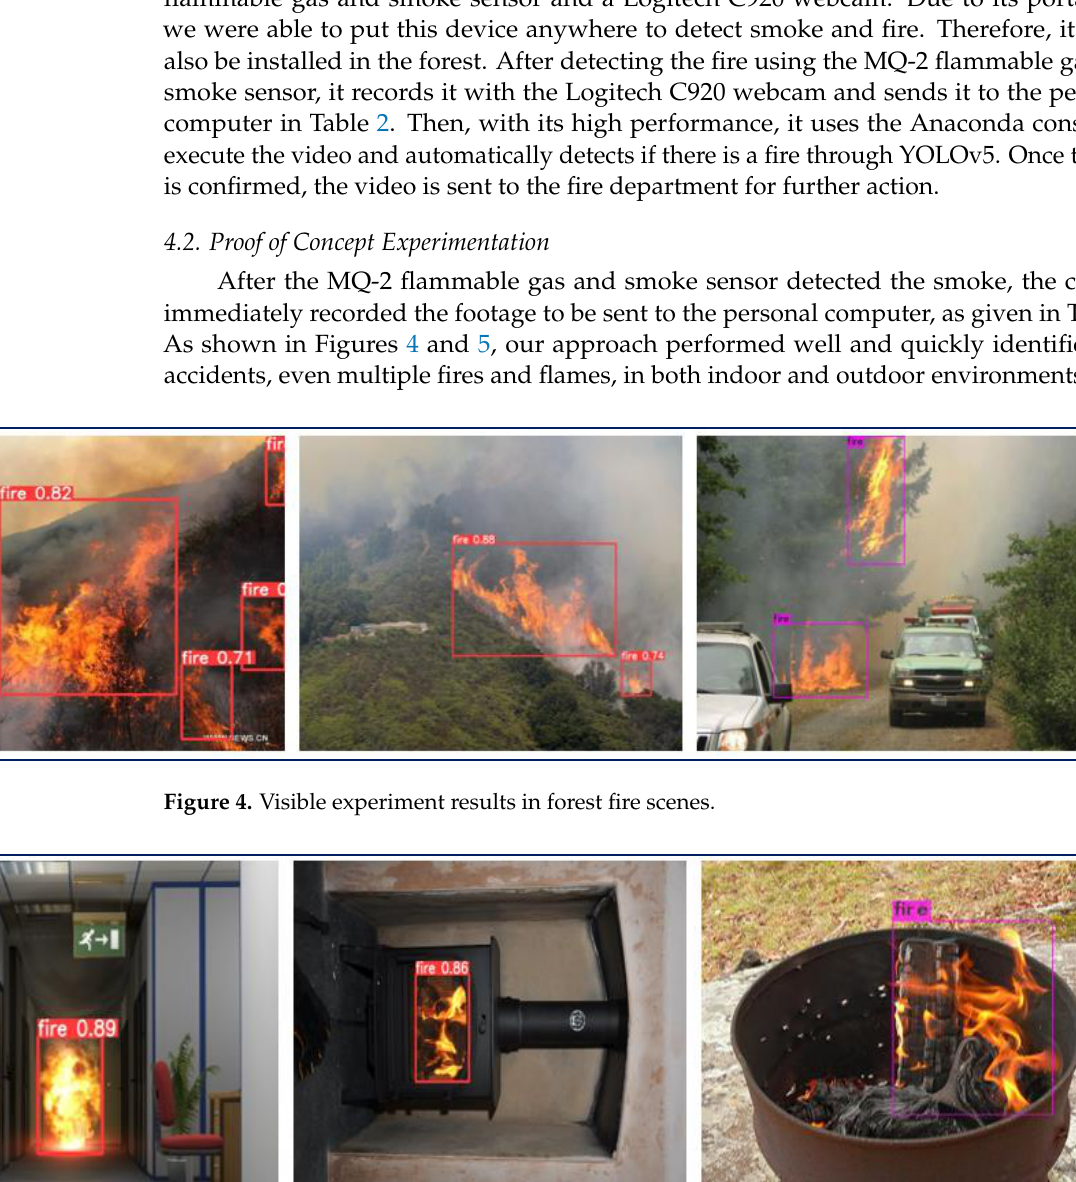
Figure 5. Visible experiment results in indoor and outdoor environments with fire scenes.